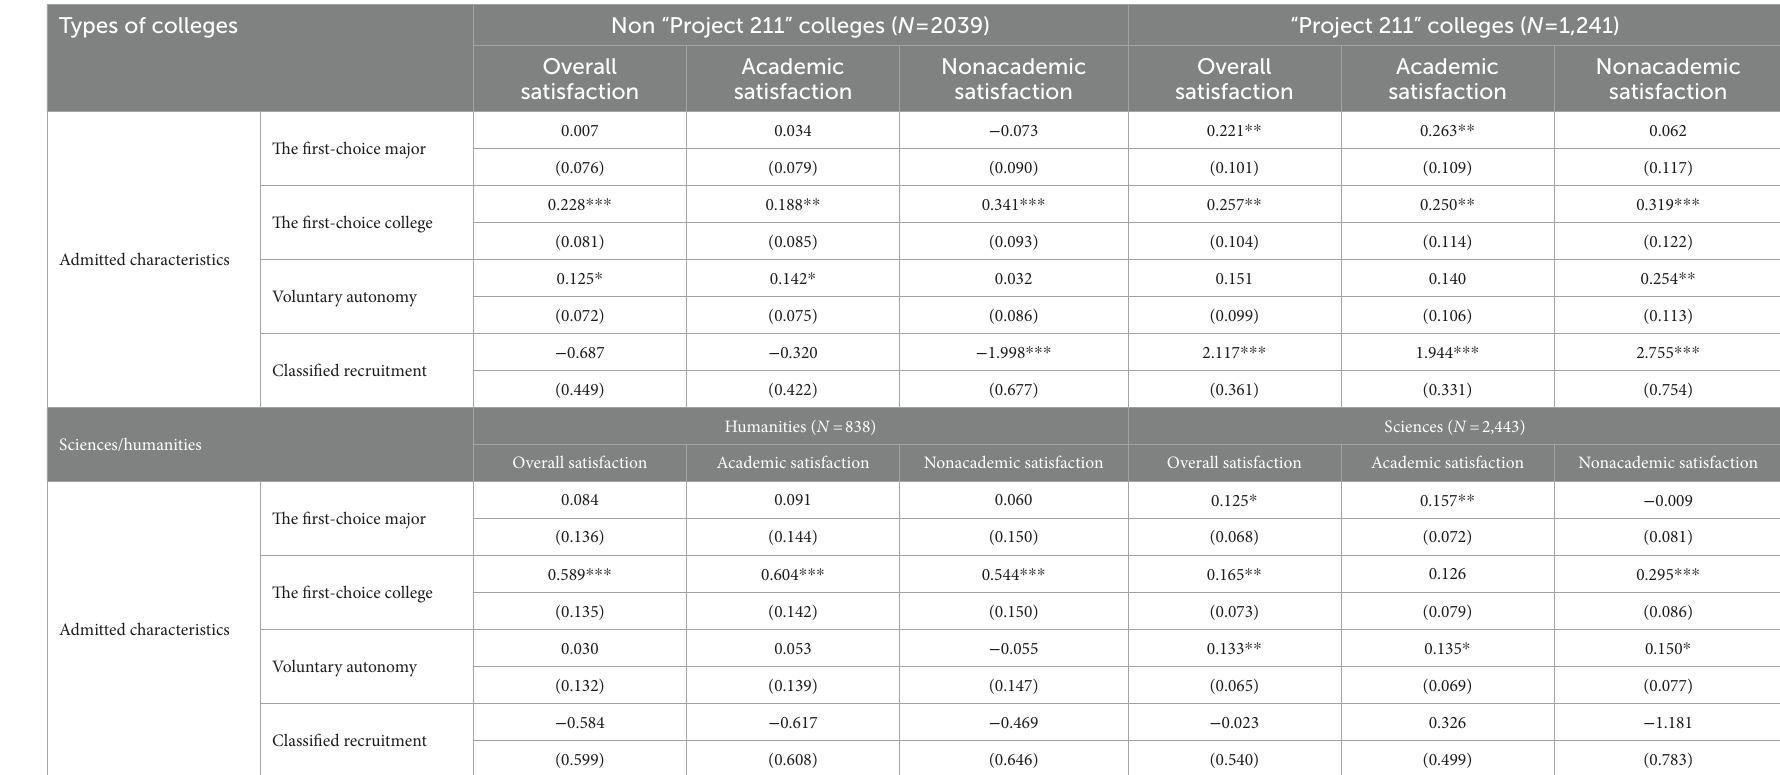
TABLE 7 The influence of college entrance examination admission characteristics on students’college satisfaction in different